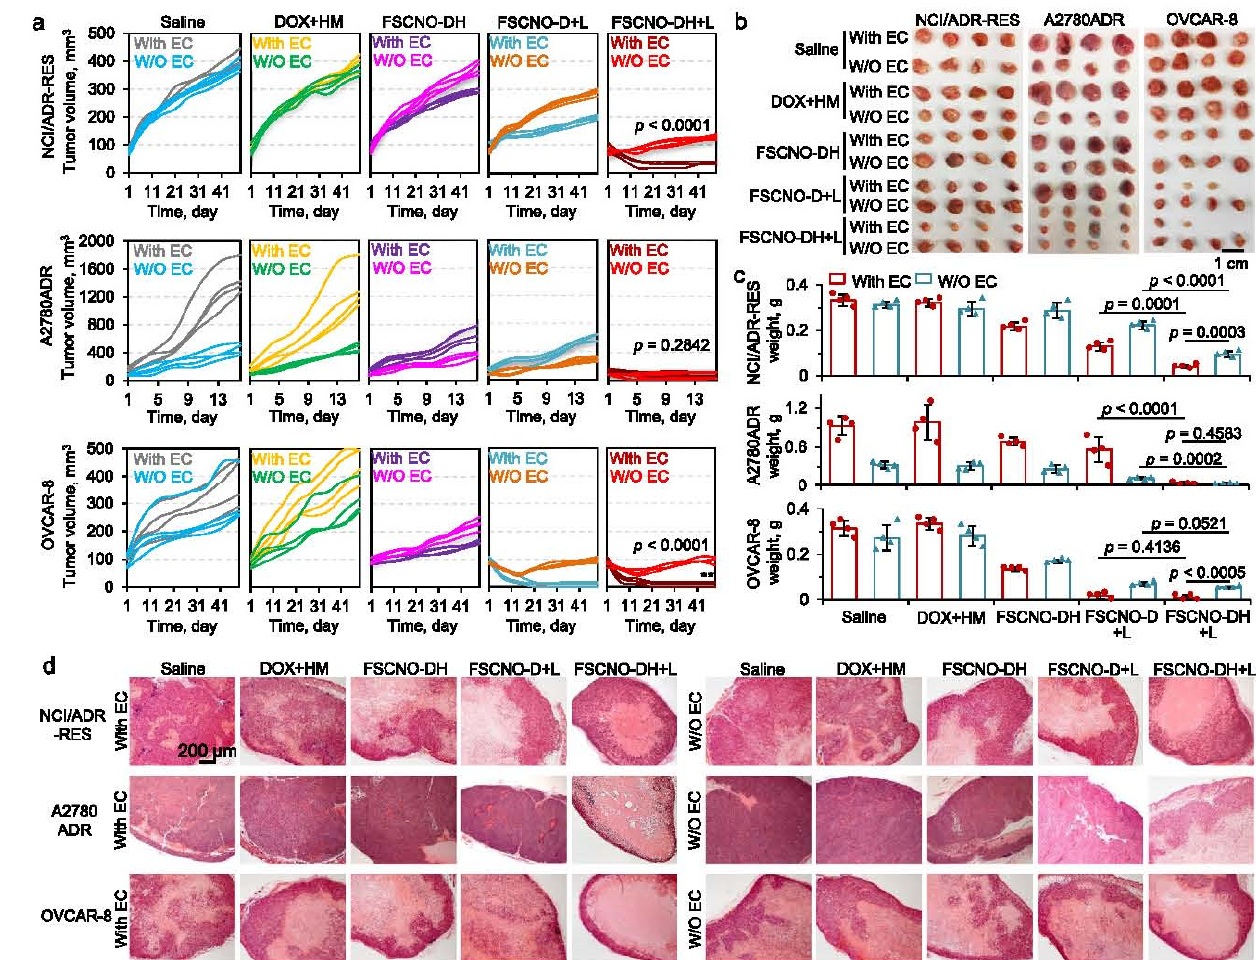
Figure 5. The capacity of the carbon nano-onion-based nanoparticles to overcome drug resistance and destroy drug-resistant tumors (NCI/ADR-RES, A2780ADR, and OVCAR-8) in vivo [92]. Growth curves ( a ), gross images ( b ), and weight ( c ) of NCI/ADR-RES, A2780ADR, and OVCAR-8 tumors with or without (W/O) co-injection of aHUVECs (With EC or W/OEC) in mice with various treatments, and representative images of hematoxylin and eosin (H&E) stained tumor tissues collected after sacrificing the mice on day 49 for the NCI/ADR-RES and OVCAR-8 groups and on day 16 for the A2780ADR group ( d ). Copyright 2021, Springer Nature.